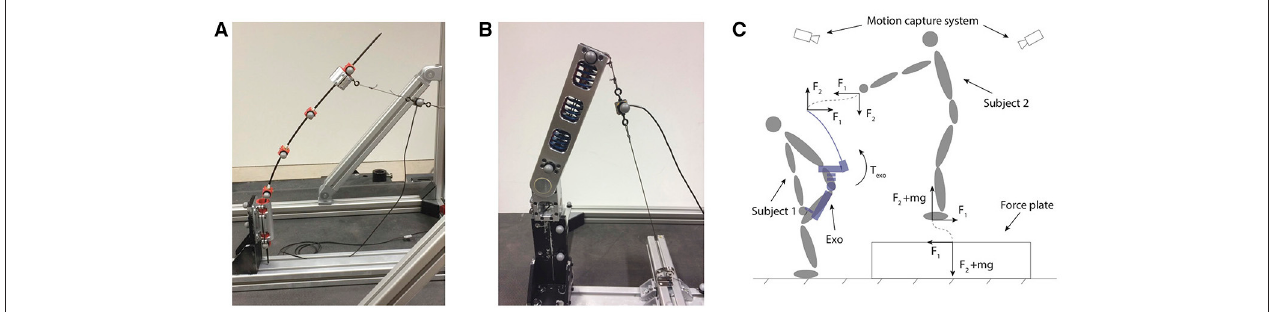
FIGURE 6 | Component testing: Spinal support (A) . The beams are tested on the one hand to identify the material properties, such as the Young’s modulus E and on the other hand to identify the torque angle characteristic. The carbon fiber beams are fixed on the base. A force, which is recorded with a load cell, is applied at the top . Five points on the beams are tracked using a motion capture system (Vicon Vero). Torque source hip (B) . In order to validate the design of the torque source and to identify the torque angle characteristic, the hip actuator is subjected to a external force. The force is recorded with a load cell, while at the same time the two markers on the rotating, top part of the actuator are tracked; Loading support verification (C) . Subject 1 is wearing the bottom part of the exoskeleton. The exoskeleton is equipped with markers, whose position is recorded with the motion capture system. Subject 2, with known mass m is standing on a force plate, while exciting the spinal part of the exoskeleton with the forces F 1 and F 2 . The known length of the spinal part of the exoskeleton allows to calculate the support torque at lumbar level τ exo .